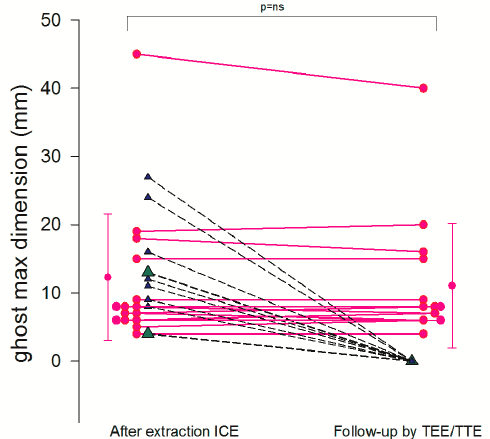
Figure 6. Ghost follow-up at 1 month. Individual value bar graph shows the destiny of the ghost as assessed by ICE (first column) and at 1 month follow-up by TEE (second column). Most of the ghost masses were still there (pink dots connected with solid line), while 7 had disappeared (triangles connected with dashed line). (2 masses, green triangles, were not assessed at follow-up because they were in an inaccessible part of the superior vena cava).